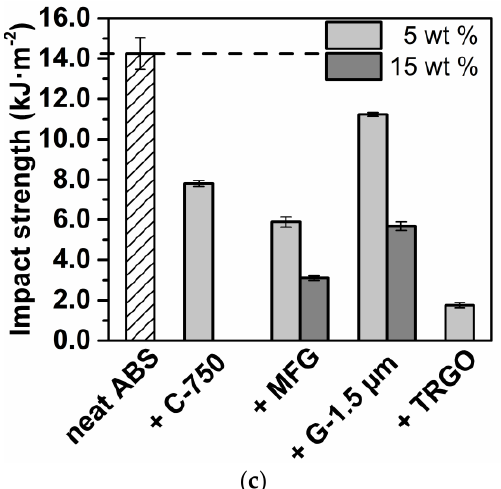
Figure 3. Young’s modulus ( a ), elongation at break ( b ), and impact strength ( c ) of carbon/ABS nanocomposites as a function of carbon type and content.